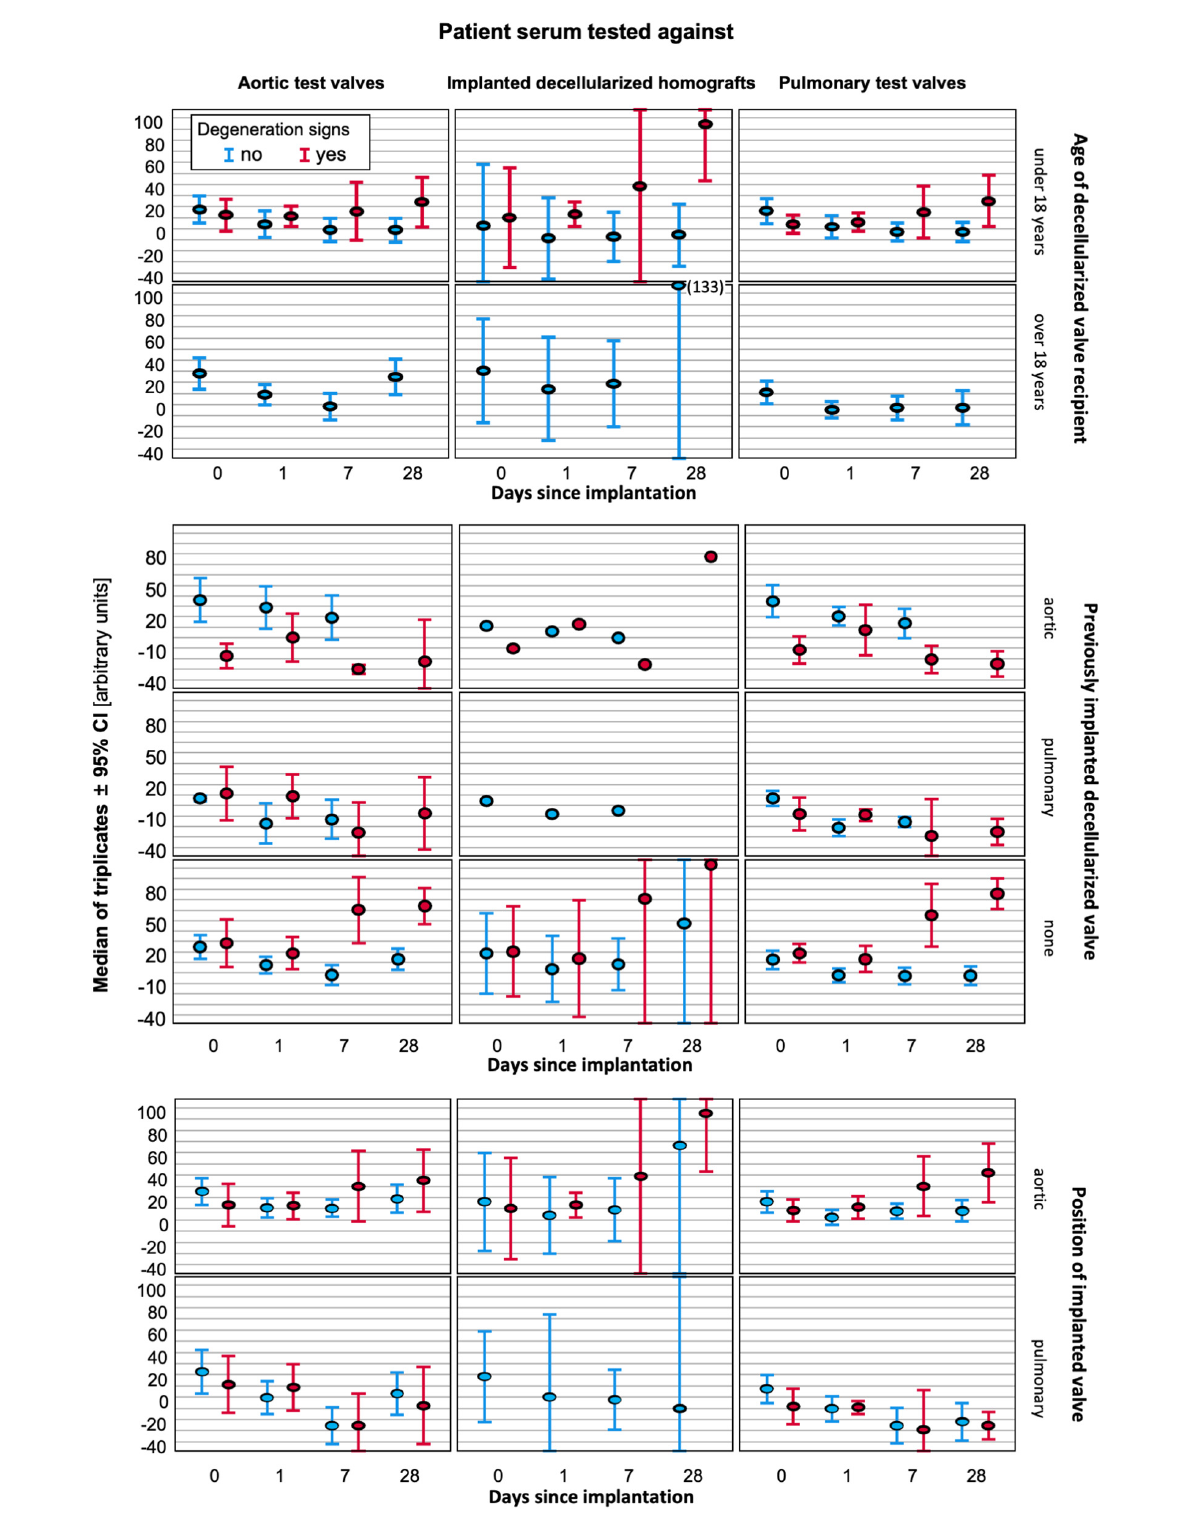
FIGURE4 Antibody binding to implanted DHV (middle column) and test valves (left column-aortic, right column pulmonary) differentiated by age (superior block), valve position (middle block), and prior DHV implantation (inferior block). In each graph, the results for patients with signs of early degeneration are marked in red, and blue indicates no degeneration at the last